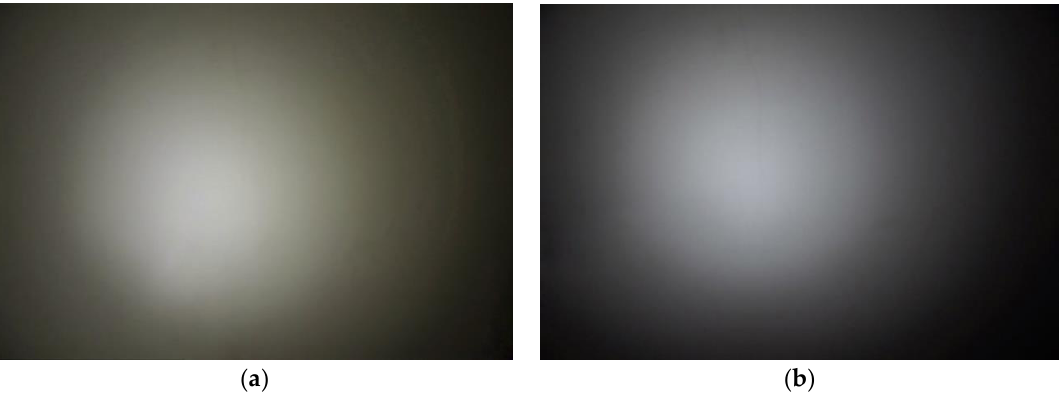
Figure 7. Light projection at 350 mA for ( a ) non-diffuser and ( b ) TiO 2 diffuser-loaded encapsulation remote phosphor LEDs.